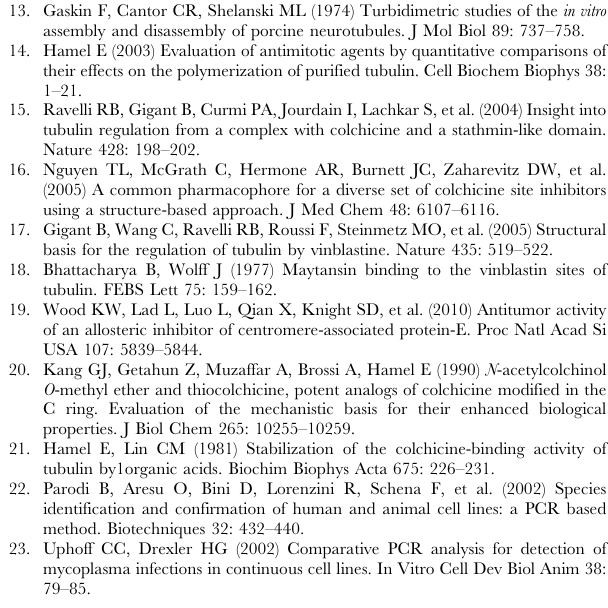
Figure S1 Fragments used to search chemical libraries for compound analogues. Fragments of compound B (6-Furan-2- yl-3-methyl-4-oxo-4,5,6,7-tetrahydro-1H-indole-2-carboxylic acid tetrahydro-furan-2-ylmethyl ester), encircled in blue and red, that were used in the computer-assisted search of compound